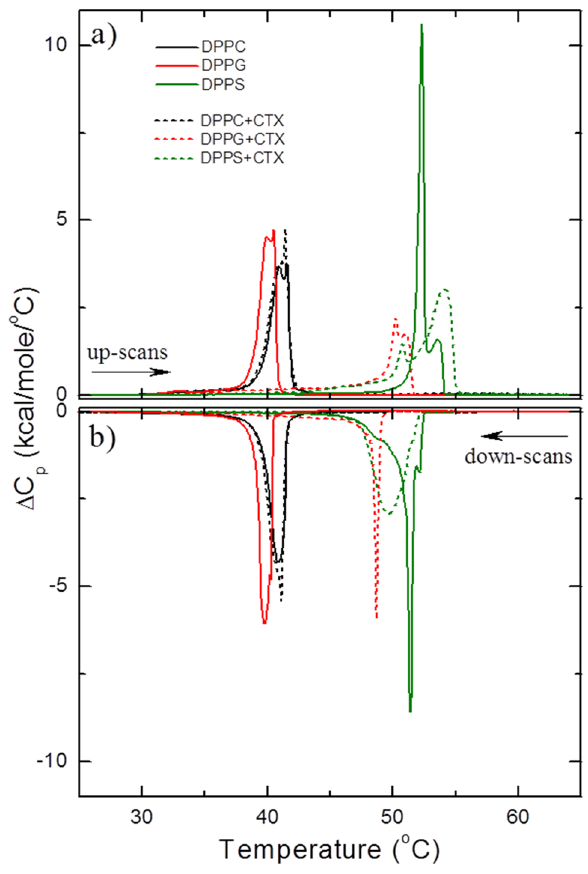
Figure 4. Typical excess heat capacity (ΔC p ) profiles of 5 mM DPPC (black), DPPG (red) and DPPS (olive), in the absence (solid line) and presence (dotted line) of 0.1 mol% CTX relative to the lipid concentration: ( a ) heating and ( b ) cooling cycles.